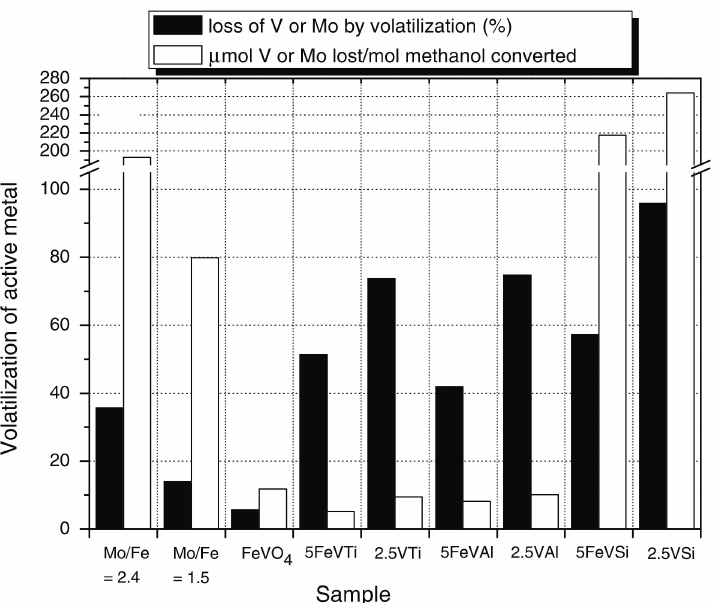
Figure 50. A comparison of the loss of V or Mo from the catalysts by volatilization during MeOH oxidation for 5 days, at 300 ◦ C feeding 10 vol.% MeOH and 10 vol.% O 2 in N 2 . 5FeV = five theoretical layers with V:Fe of 1:1 on support; 2.5 V = 2.5 theoretical layer of vanadia on support. Al = α -Al 2 O 3 ; Ti = TiO 2 ; Si = SiO 2 . Reprinted with permission from [214] Springer Science+Bussiness Media. Copyright © (2011).